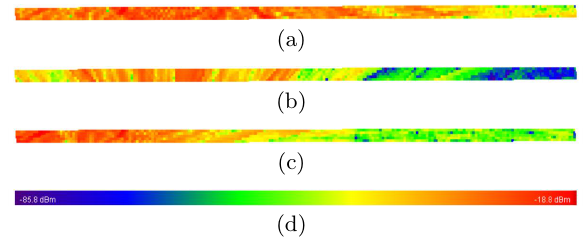
Figure 1: RSS of (a) omnidirectional antenna, (b) directional antenna facing east and (c) directional antenna facing north. (d) RSS intensity.